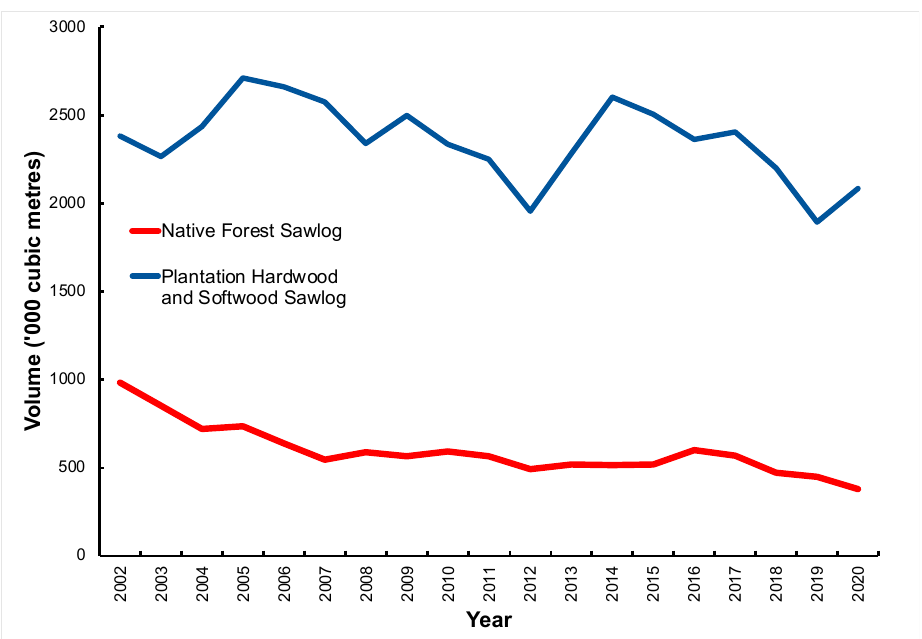
Figure 4. Volume of hardwood pulp logs from native forests and plantations (derived from ABARES 2021 data).